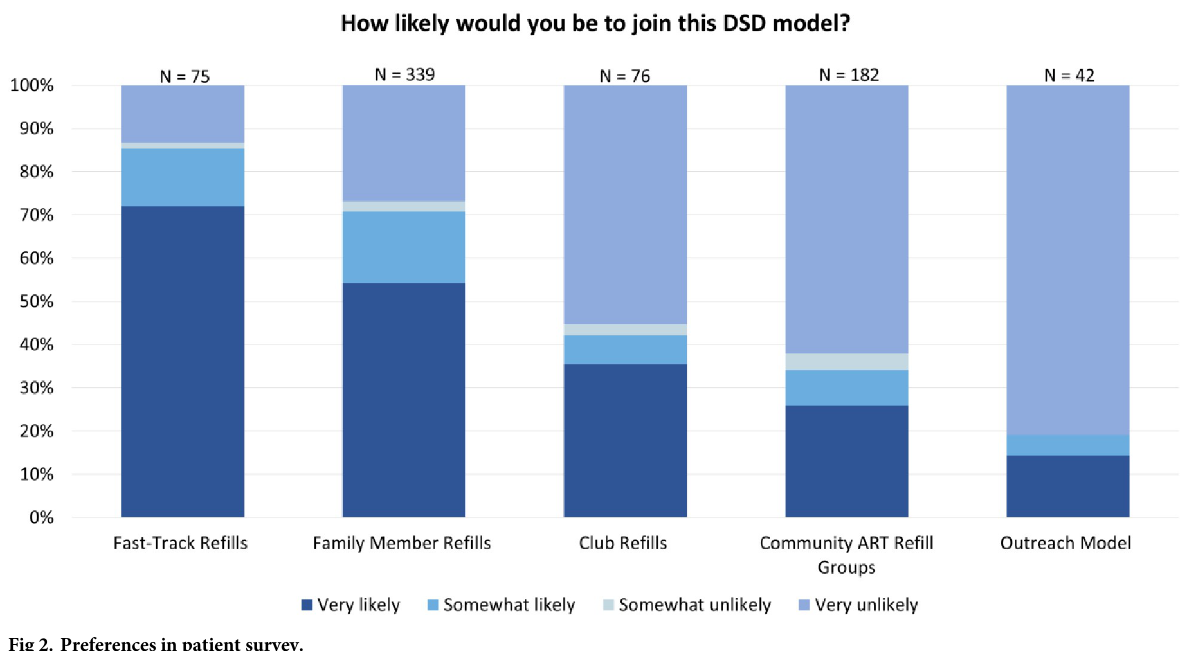
Fig 2. Preferences in patient